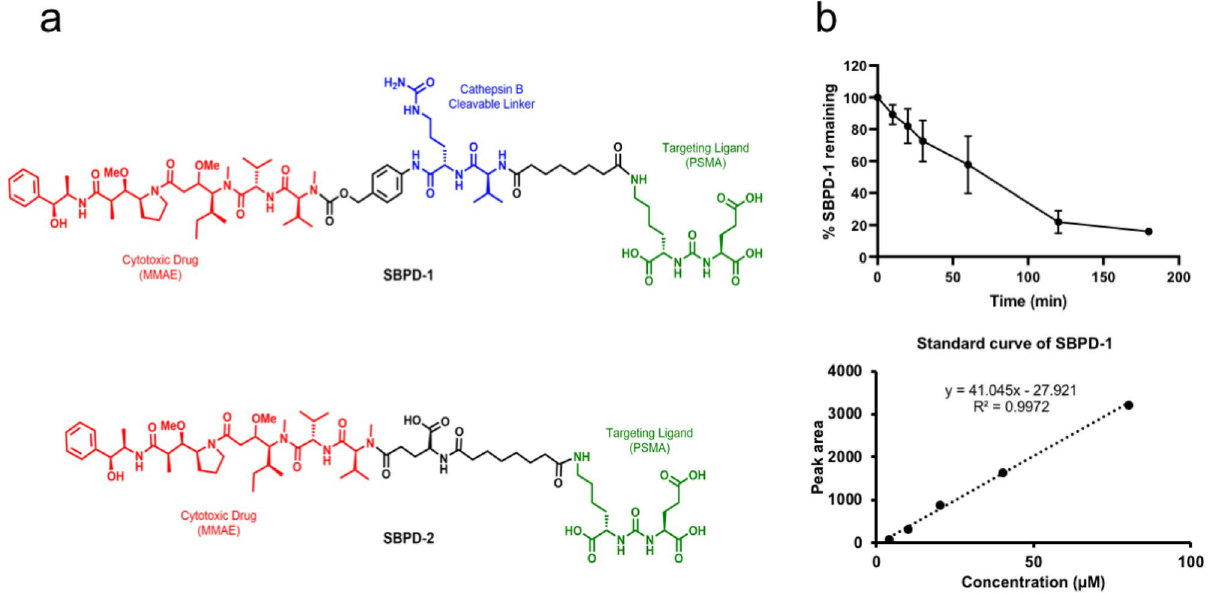
Figure 1. SBPD-1 is a PSMA-targeted prodrug that releases MMAE through the action of cathepsin B. ( a ) Structures of SBPD-1 and SBPD-2. PSMA-targeting moiety (green), linker (black), cathepsin B cleavable linker (Blue), and MMAE (red). ( b ) Release of MMAE upon treatment of SBPD-1 with recombinant cathepsin B represented by decrease of intact SBPD-1 (upper). Standard curve generated for the quantification of intact SBPD-1